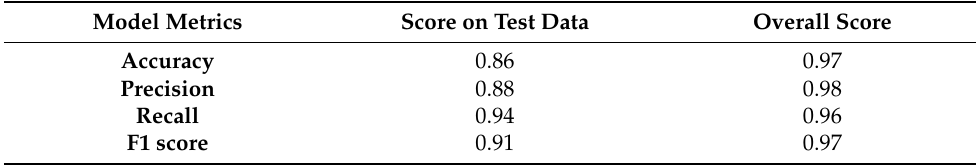
Table 2. Model performance of the random forest classifier, measured on test dataset.